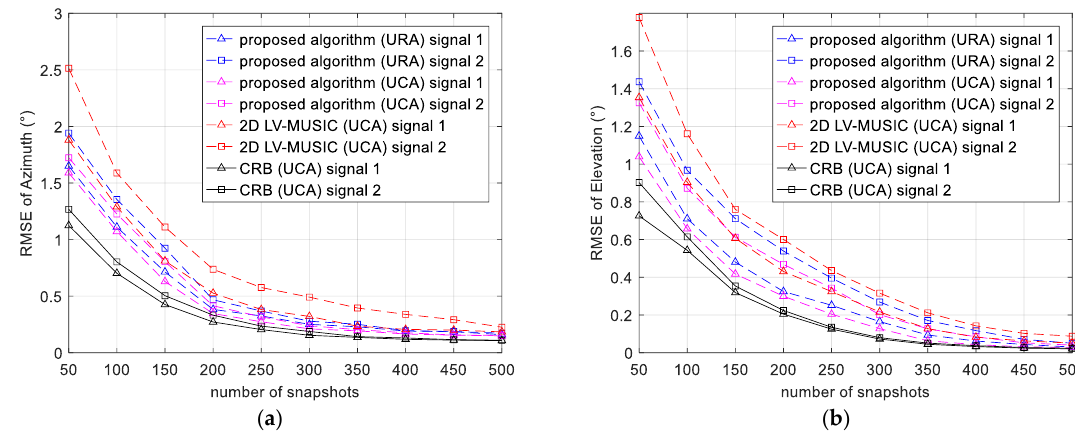
Figure 6. RMSE and CRB of ( a ) azimuth and ( b ) elevation versus number of snapshots (for SNR = 10 dB).